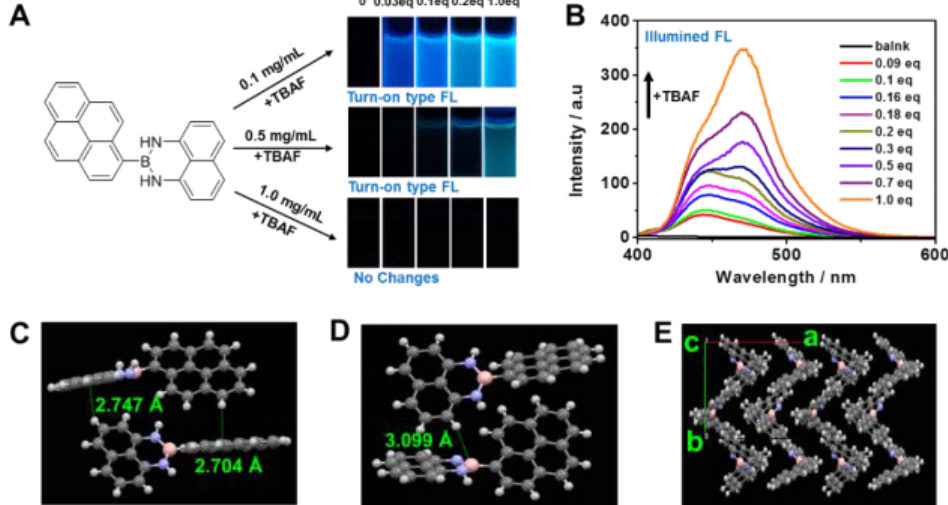
Figure 5. The responsive behaviors of Py-NBN-Naphth. ( A ) Schematic diagram with the addition of fluoride ion at different concentrations; ( B ) Emission spectra with the addition of different amounts of TBAF; ( C – E ) Single-crystal structures.